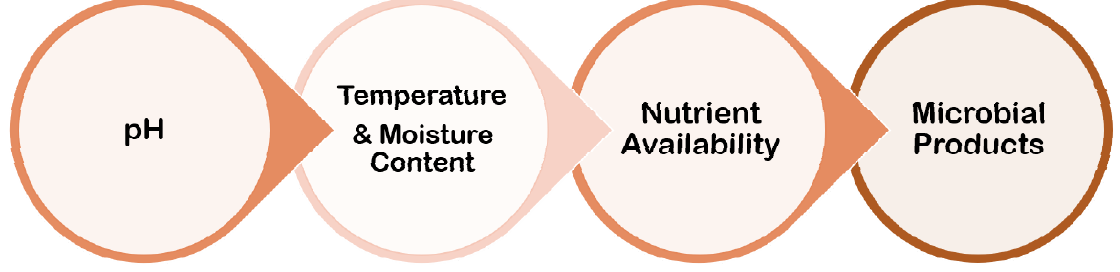
Figure 7. Several parameters related to environmental conditions for biofilm formation.